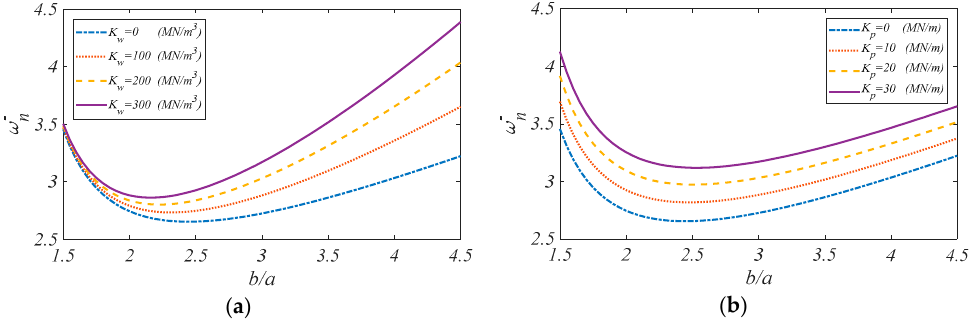
Figure 6. The e ff ect of Winkler–Pasternak coe ffi cient on the nondimensional natural frequency of MHCAP with clamp-clamp boundary conditions for di ff erent outer radius to inner radius ratios and Figure 6. The effect of Winkler–Pasternak coefficient on the nondimensional natural frequency of h / b = 0.1, UTR , T i = 273 [K], T o = 300 [K], θ = π / 4, W CNT = 0.02, V F = 0.2, FG-A, β = 1, ( a ) K p = 0, MHCAP with clamp-clamp boundary conditions for different outer radius to inner radius ratios and h/b = 0.1, UTR , T i = 273 [K], T o = 300 [K], θ = π /4, W CNT = 0.02, V F = 0.2, FG-A, β = 1, ( a ) K p = 0, and ( b ) K w = 0. ( a ) Winkler coefficient; ( b ) Pasternak coefficient.